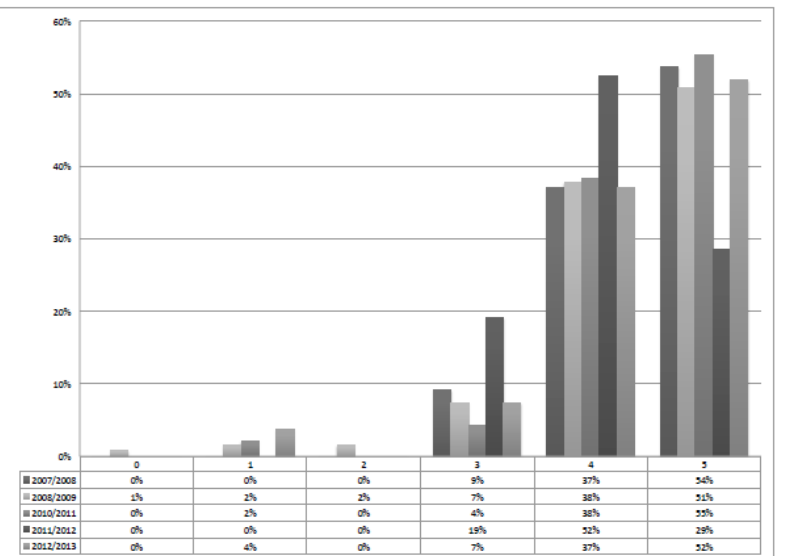
Figure 11. JavaVis is useful for laboratory assignment